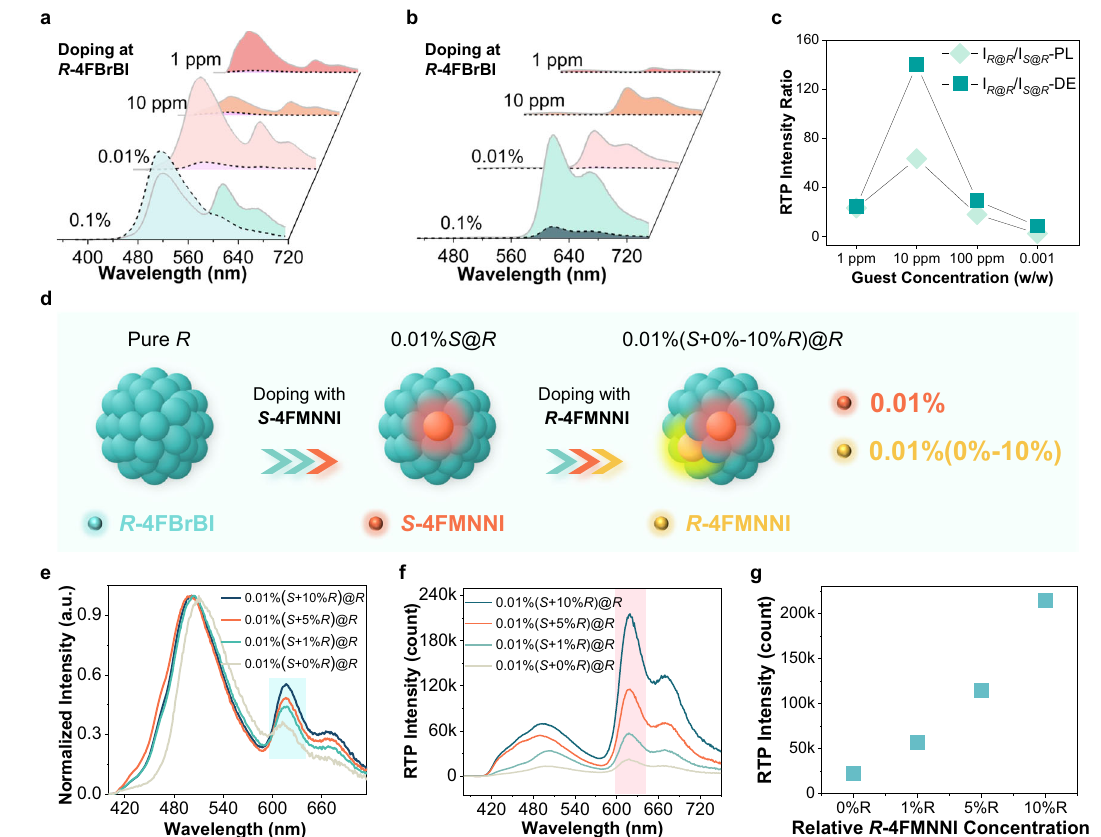
Fig. 2 | The in fl uences of different guest – host ratios and enantiomeric excess (ee)values.a Steady-statePLspectraof R -4FMNNI (solidborderline)or S -4FMNNI (dash borderline) dopants ( w / w 1ppm-0.1%) in R − 4FBrBI solid (namely, R @ R and S @ R )inairat298K( λ Δ t =0.1ms)spectraof R ex =365nm). b Delayedemission(DE, − 4FMNNI (dashborderline)and S − 4FMNNI (solidborderline)guests( w / w =1ppm- 0.1%) in R − 4FBrBI solid in air at 298K ( λ ex =424nm). c The ep (I R @ R /I S @ R ) value ( I represent the intensity of PL emission at 620nm or DE emission at 615nm) vs. concentration of guest dopants ( w / w =1ppm-0.1%). d Measurements preparation schematicdiagramfor samplesin e – g withdifferent ee values: Pure R − 4FBrBI fi